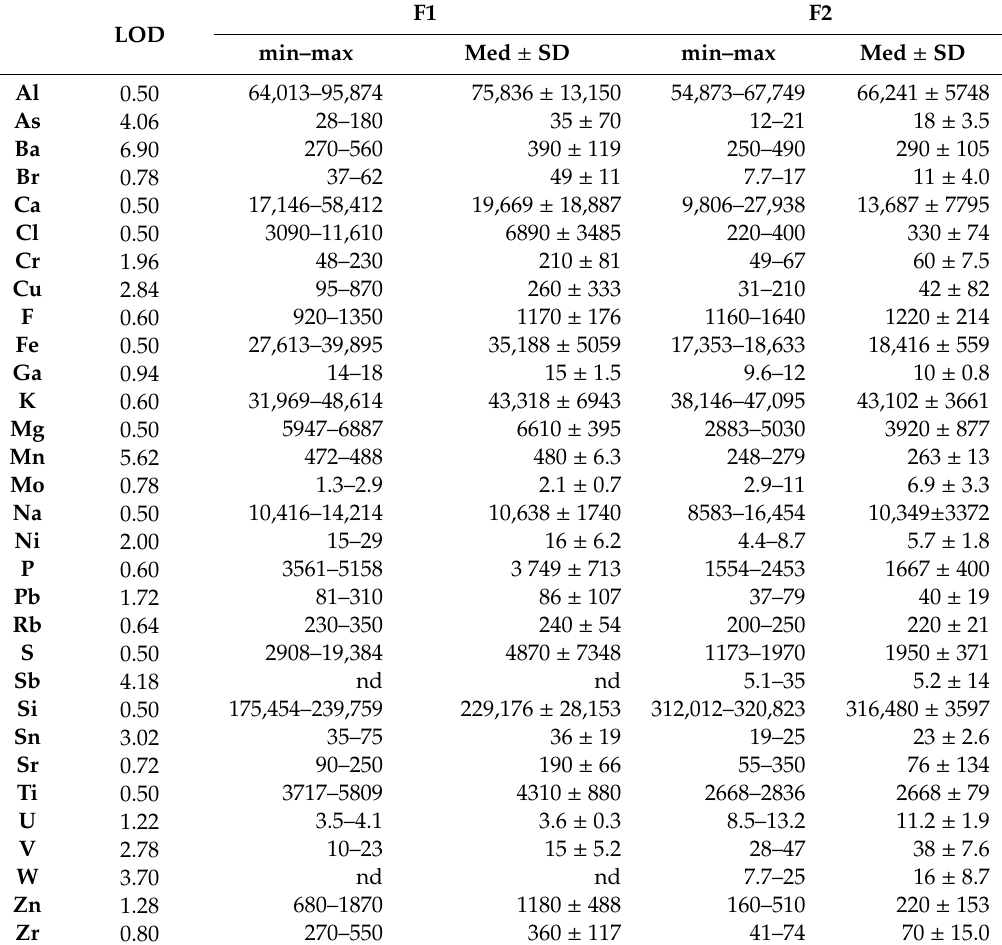
Table 1. Summary descriptive statistics of elements analysed in two size fractions of road dusts from three selected locations. Concentrations in mg kg − 1